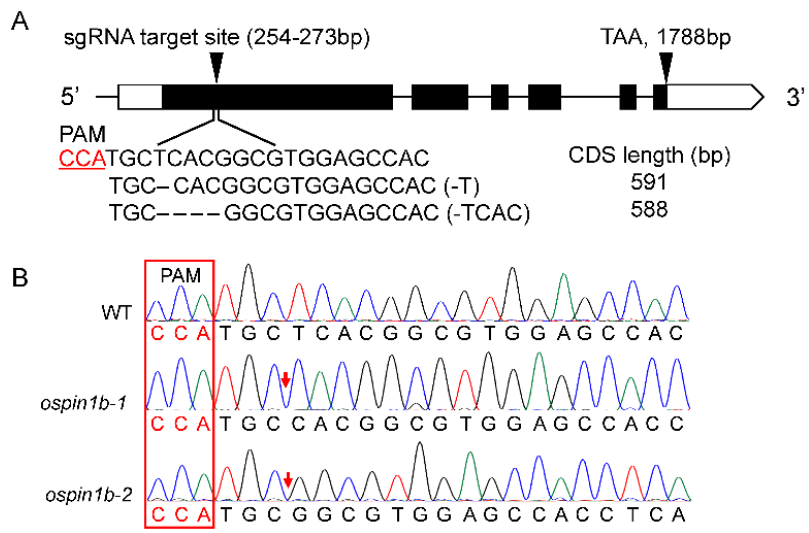
Figure 3. Schematic diagram of OsPIN1b gene mutation sites. ( A ) Gene structure of OsPIN1b and the sequence of the sgRNA target site. ( B ) A total of 1- and 4-bp nucleotides were deleted in the ospin1b-1 and ospin1b-2 , respectively. The red arrow shows the mutation site.